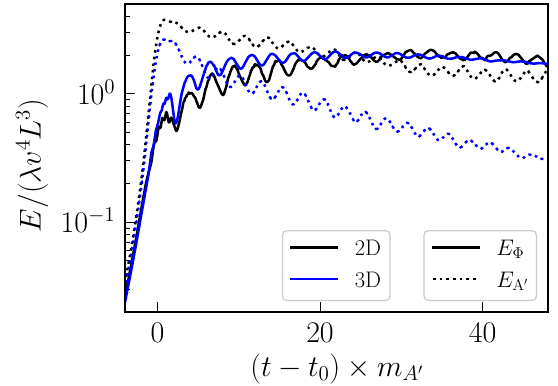
Figure 9 . Energy in the scalar field (including interaction energy with the vector; solid lines) and energy in the vector field (not including interaction energy; dashed lines) as a function. We compare two cases with λ/g 2 = 25 : one where a translational symmetry is enforced in one spatial direction D (black lines labelled 2D), and one where on symmetries are enforced (blue lines labelled